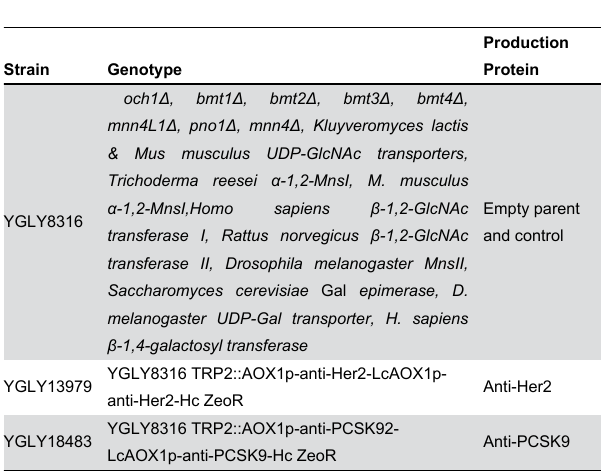
Table 1. Strains used in this